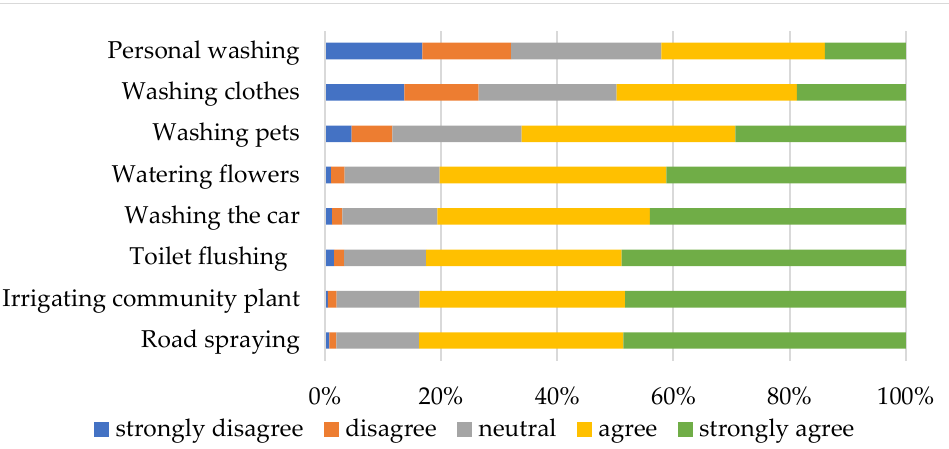
Figure 2. Urban residents’ acceptance intention to use recycled stormwater for various residential uses.